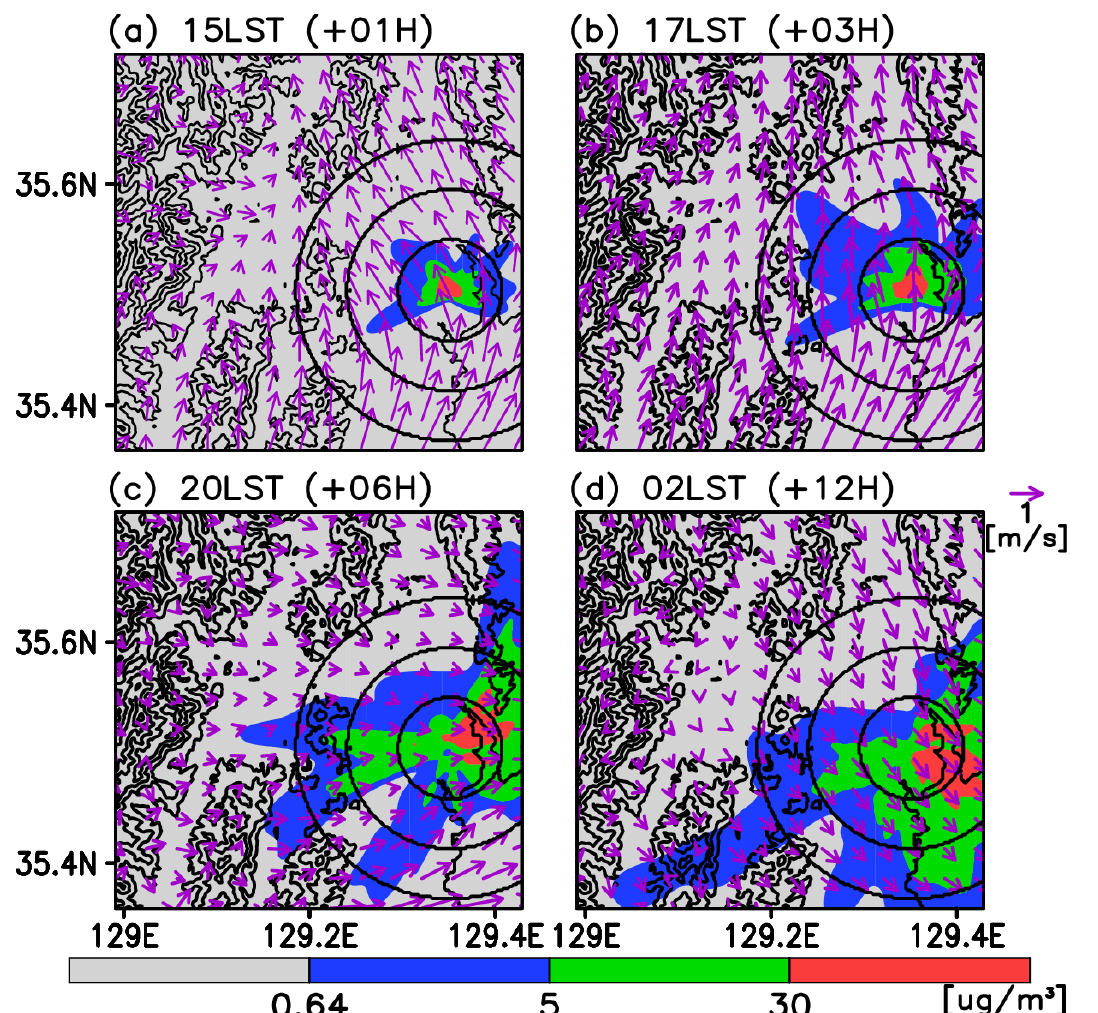
Figure 5. Time ‐ averaged benzene concentration (shaded, unit: μ g m − 3 ) and surface wind (arrow, unit: m s − 1 ) of the daytime emission ‐ started cases. Each panel shows the patterns at ( a ) 15:00 LST, ( b ) 17:00 LST, ( c ) 20:00 LST, and ( d ) 02:00 LST, which are 1, 3, 6, and 12 h after the emission starts, respectively. Also shown is the topography (contour in black). Three circles indicate the distance from the emission source to 5, 10, and 15 km.